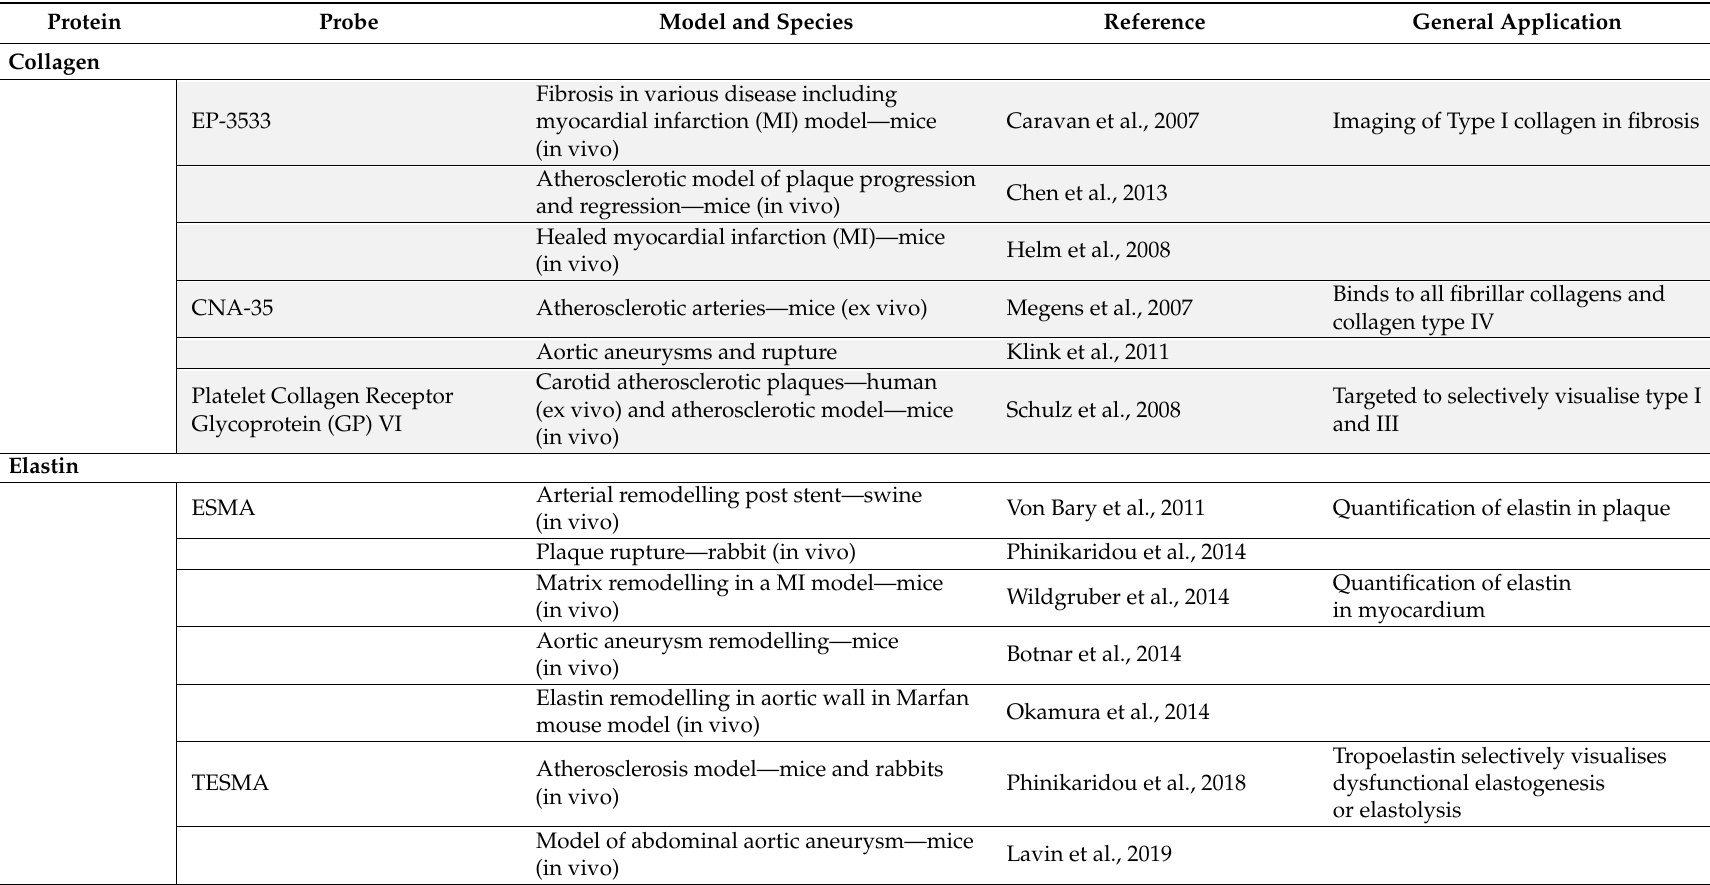
Table 2. Summary of recent probe development in the field of cardiovascular disease (CVD) with indication to the ECM structure that they